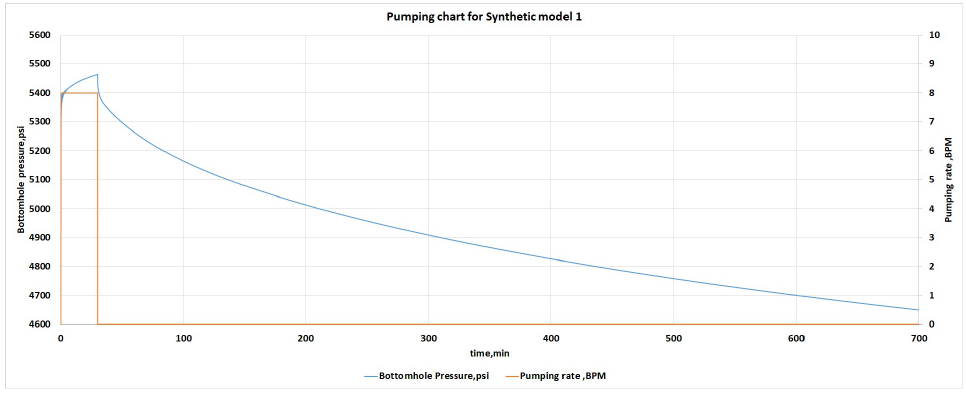
Figure 8. Synthetic model 1 pumping chart.